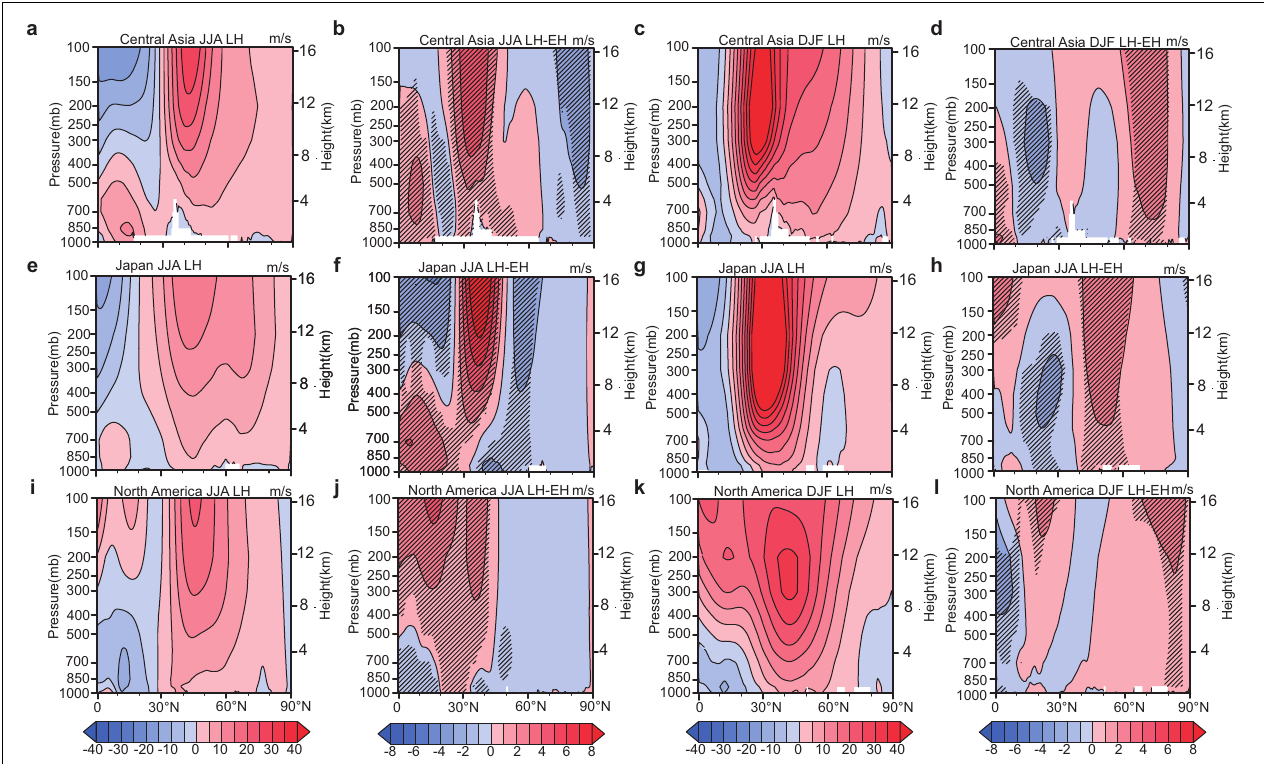
FIGURE 5 | Vertical profile of zonal mean westerly winds in boreal summer and winter averaged for Central Asia (a–d) , Japan (e–h) , and North America (i–l) . The values for LH and the differences between LH and EH are both shown. Black shades indicate the differences at the 95% significance level.